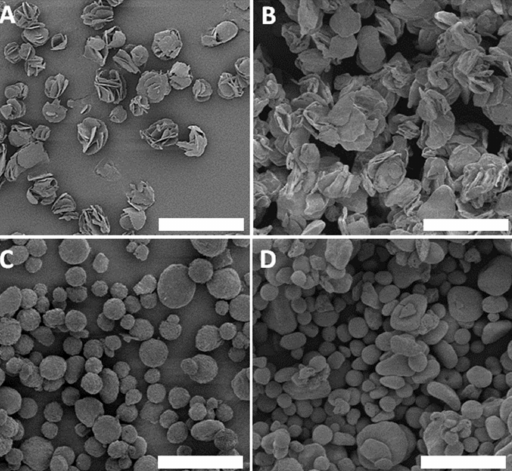
Figure 3. SEM imaging from four experiments during our investigations to determine our formulation.